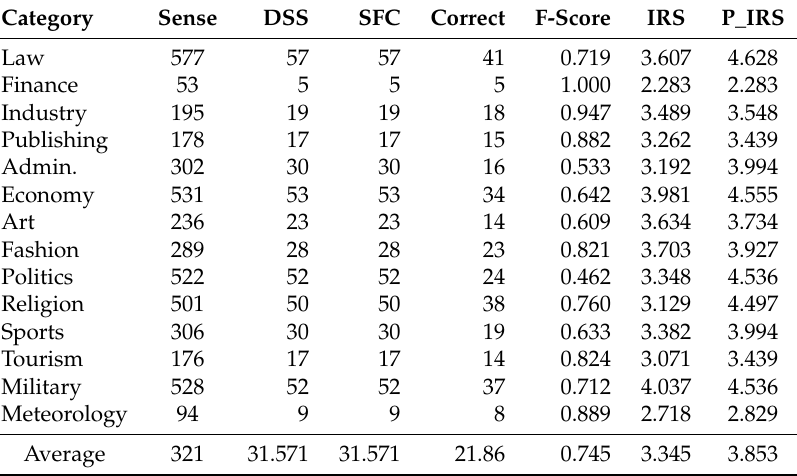
Table 2. The results of sense